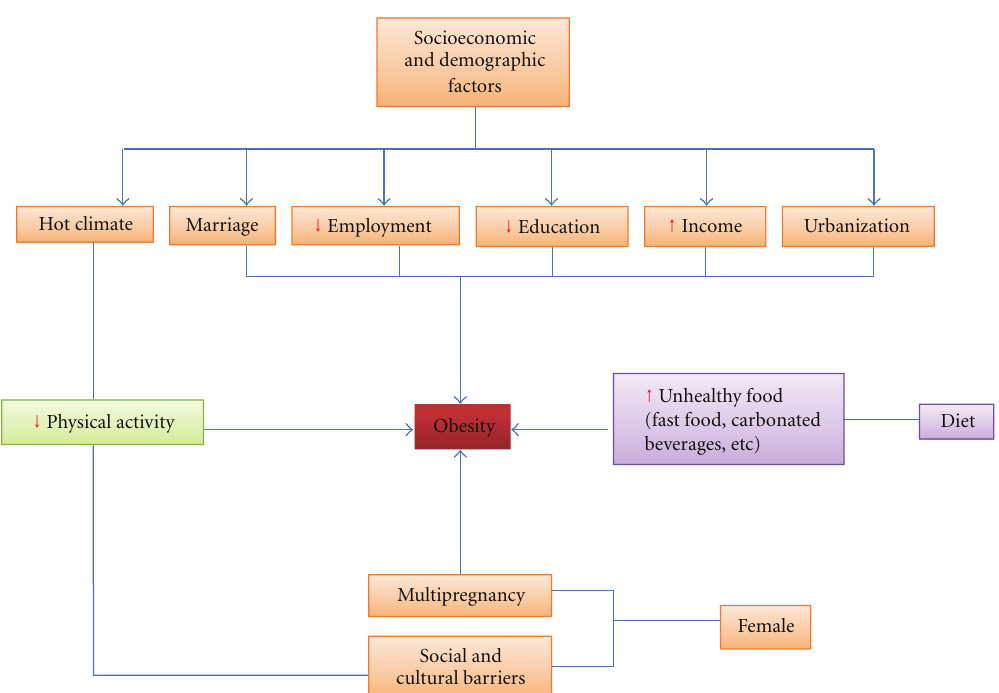
Figure 4: Diagram illustrating the factors that may lead to obesity in the Arabic-speaking